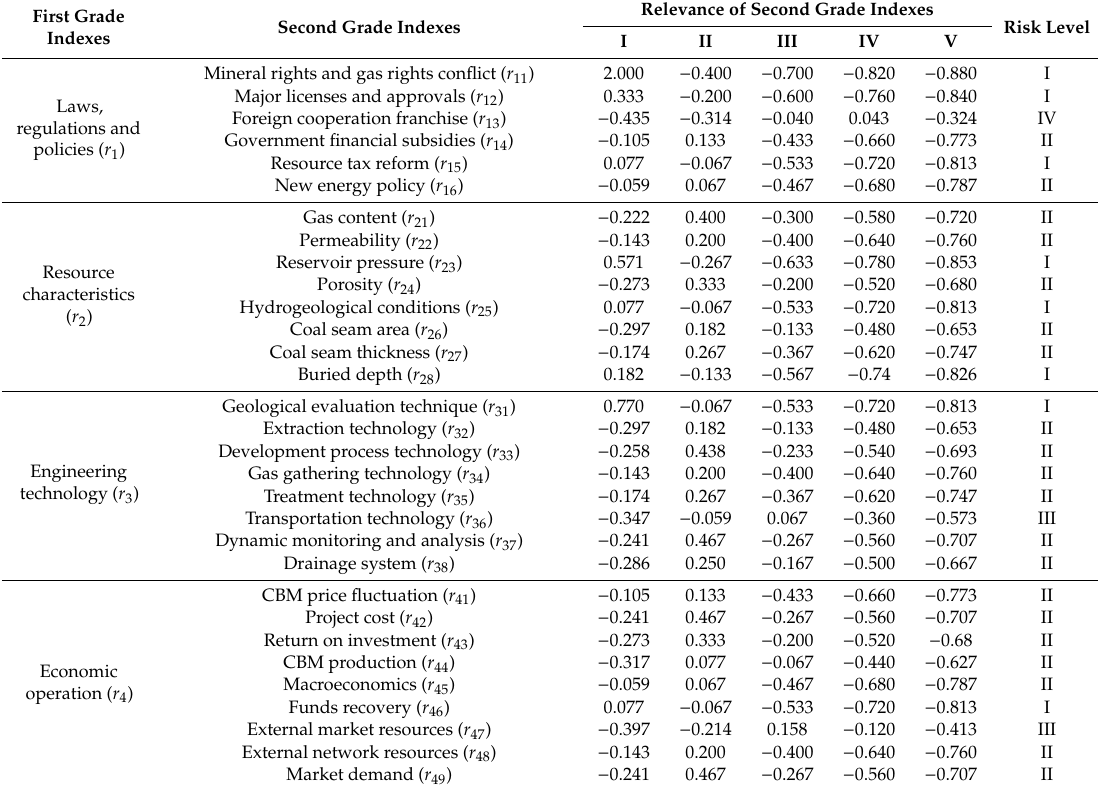
Table 6. The relevance of second grade